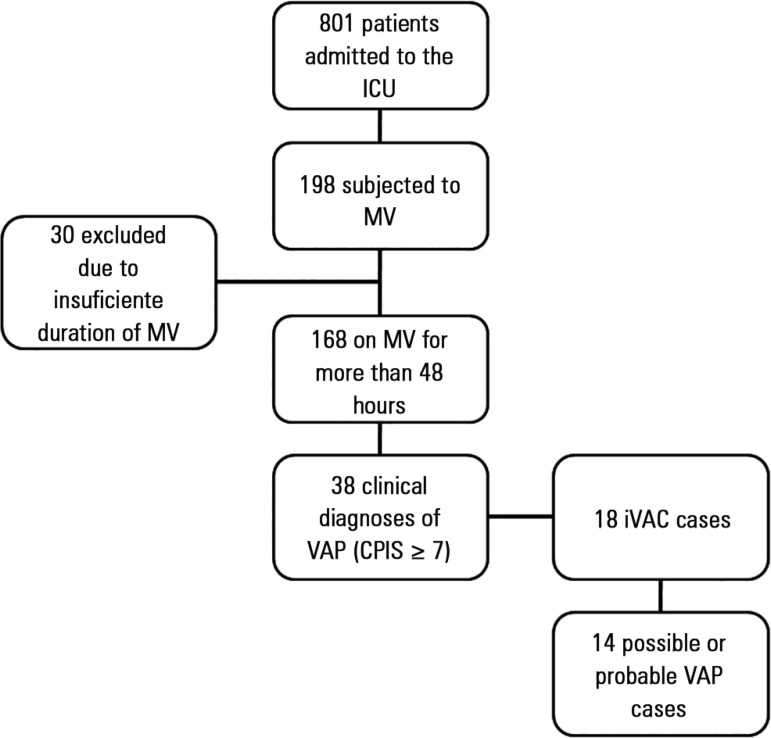
Flowchart of patient inclusion over the course of the study.ICU - intensive care unit; MV - mechanical ventilation. CPIS - clinical pulmonary
infection score; VAP - mechanical ventilator-associated pneumonia; iVAC -
infection-related ventilator-associated complications.